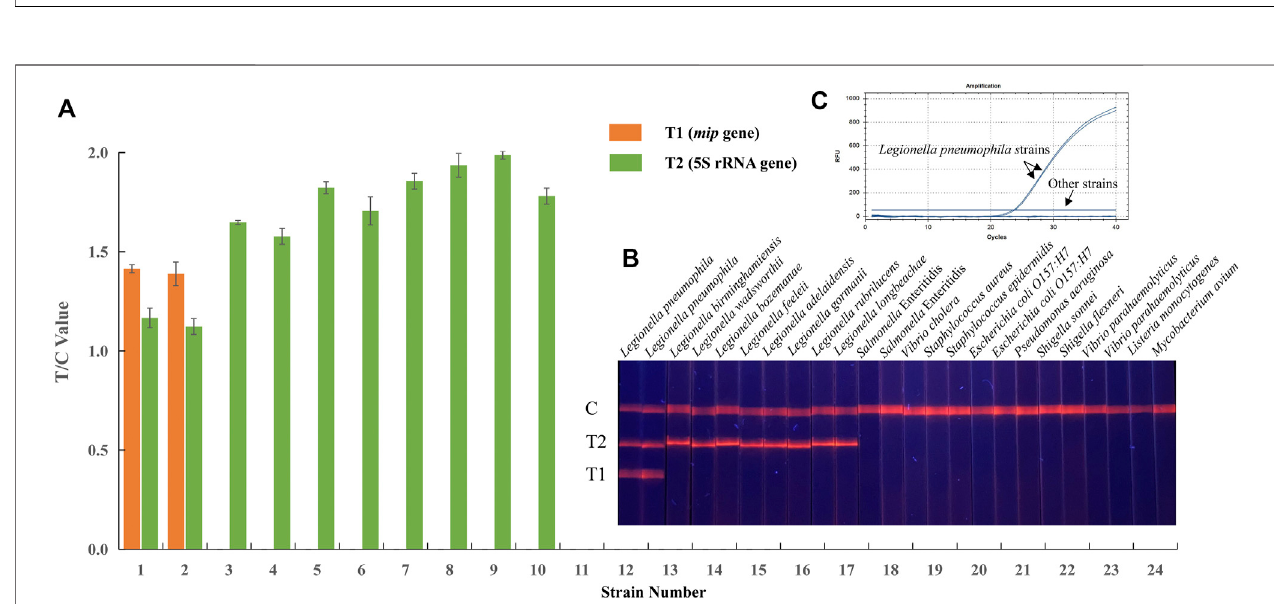
FIGURE 4 | Speci fi city of EuNPs-LFIC-RPA and qPCR assays for Legionella pneumophila . (A,B) The light signal was read out by the FIC-S2011-B14 fl uorescent strip reader. (C) The similar results obtained by qPCR assays.